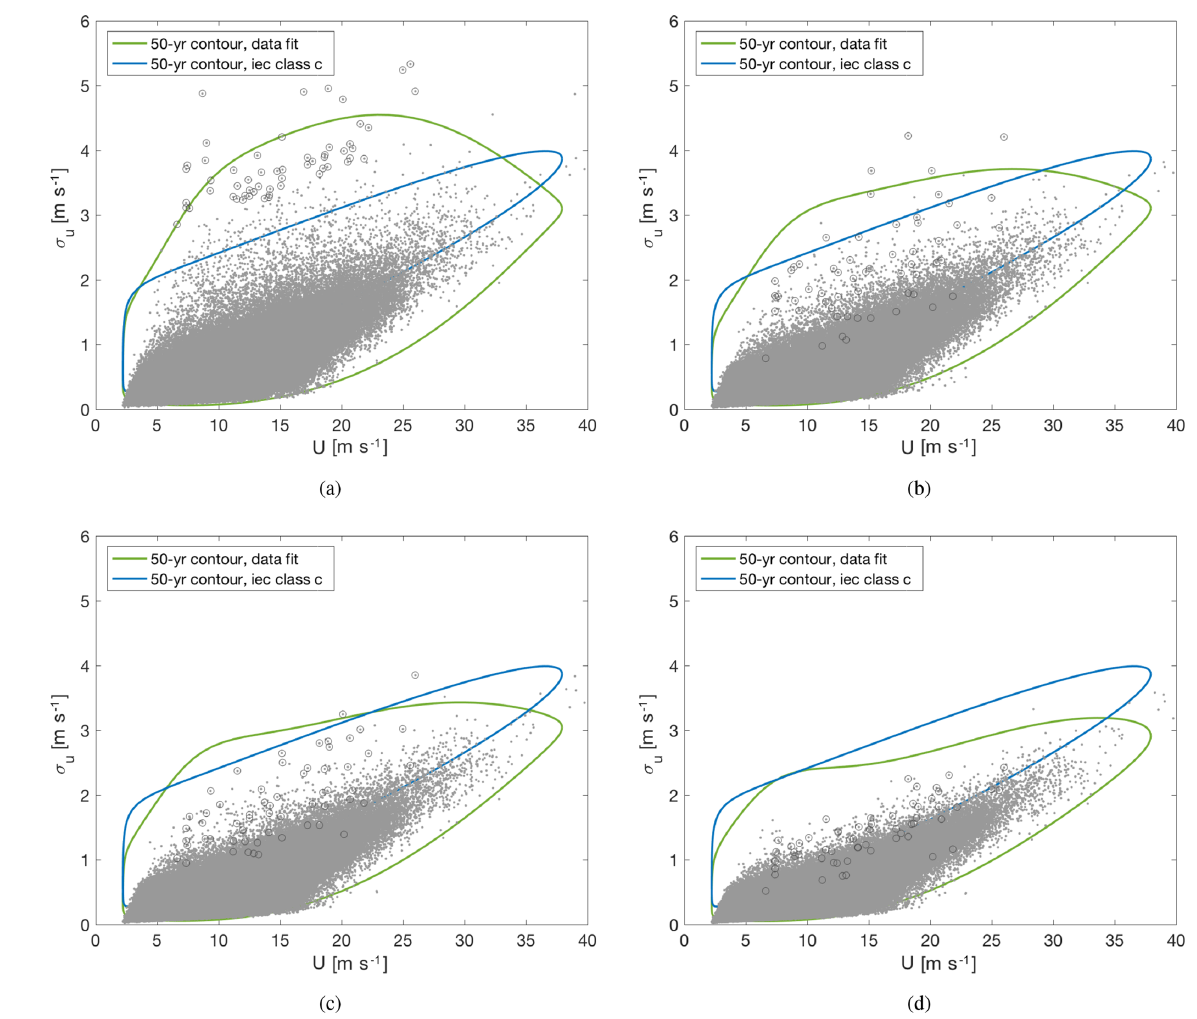
Figure 5. The 50-year return period contours based on the measurements (green curves) and the IEC expressions (blue curves). The grey dots show the measurements. (a) Raw measurements. (b) Linearly detrended measurements. (c) High-pass-filtered measurements with a cutoff frequency of 1 / 600Hz. (d) High-pass-filtered measurements with a cutoff frequency of 1 / 300Hz. The dark grey circles indicate the extreme variance